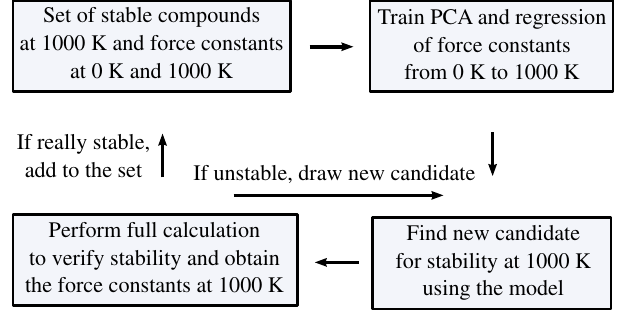
FIG. 4. Depiction of strategy for exploring the relevant com- binatorial space of compounds that are mechanically stable at high